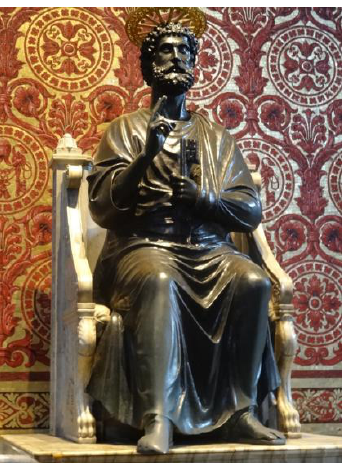
Figure 8. Bronze Statue of Saint Peter (Arnolfo Di Cambio, St. Peter ’ s Basilica, Rome, Italy). Ph credits Jordiferrer, CC BY-SA 4.0 <https://creativecommons.org/licenses/by-sa/4.0, accessed on 31 July 2021>, via Wikimedia Commons.